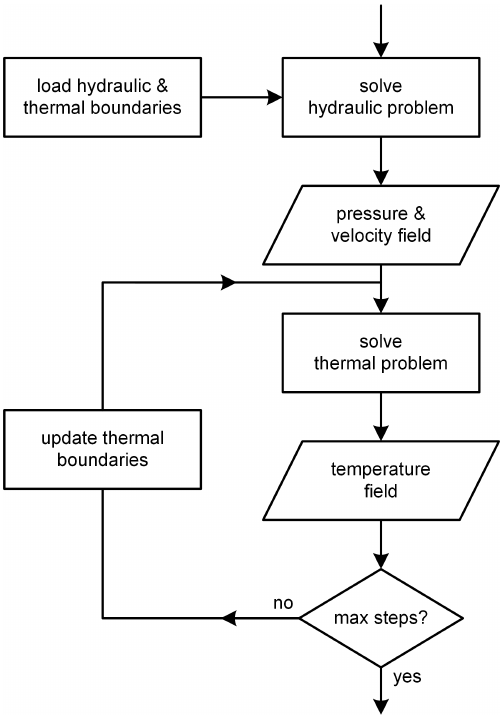
Figure 1. Flowchart illustrating the thermohydraulic calculation scheme for one hydraulic calculation step and user-defined number of thermal calculation